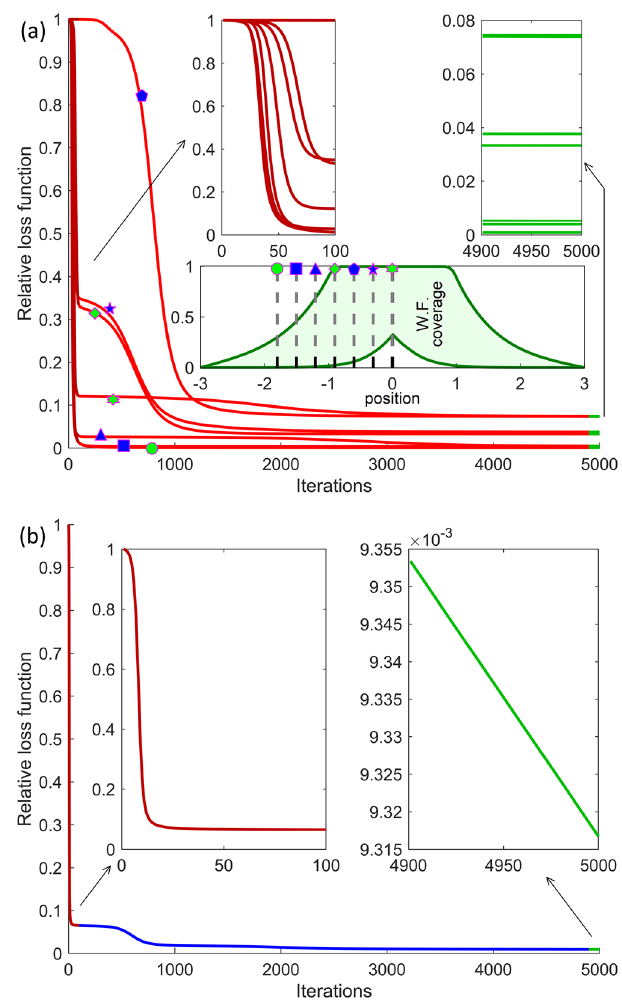
Figure 3. ( a ) Learning curves of several subnets in NN ( a ). The lower inset indicates each subnet position in the spatial domain. The upper left inset details the behavior of the loss curves for the first 100 iterations. The upper right inset indicates the values of the relative loss function at the end of the learning cycle. ( b ) Learning curve of NN ( b ). The left/right inset shows the descent of the loss curve for the first/last 100 iterations. For both ( a ) and ( b ) plots the discrete points have been connected with solid